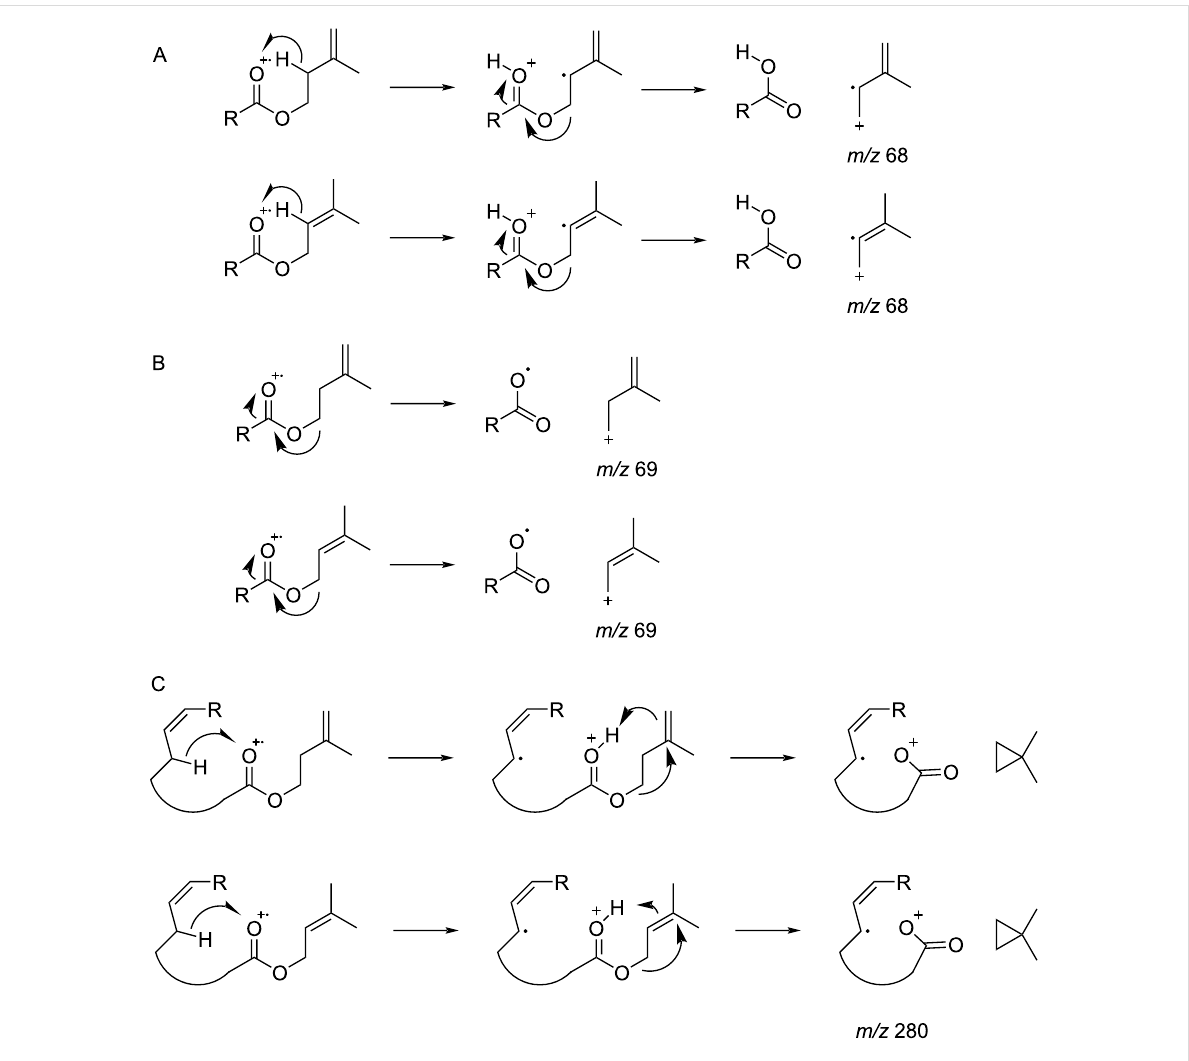
Figure 3: Proposed mass spectrometric formation of characteristic ions in prenyl and isoprenyl esters. Formation of m / z 68 (A), m / z 69 (B), and m / z 280 (C).